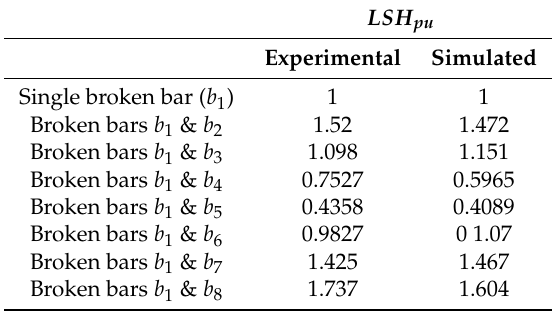
Figure 17. Comparison between the simulated and the experimental data obtained for the motor with one broken bar (first column), and with two broken bars separated a variable number of healthy bars. Table 2. Comparison between the ratio LSH pu of Equation (52) computed with the experimental tests and with the simulated